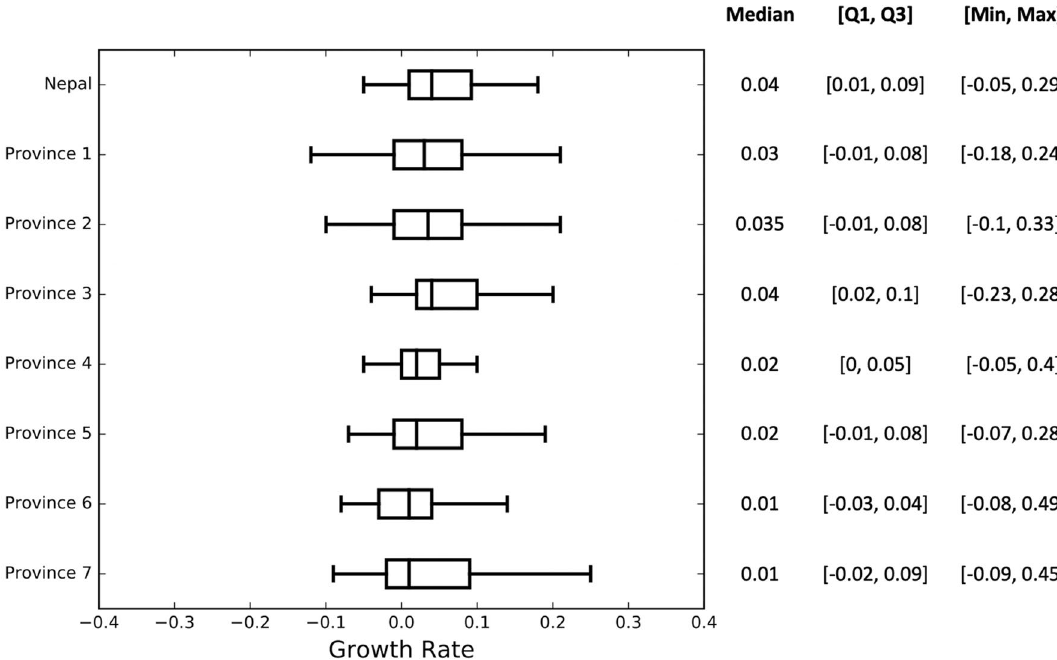
Figure 3. The five number summary (median, lower quartile, upper quartile, minimum, maximum) and the corresponding box plots of the daily exponential growth rates in Nepal and its provinces during the entire epidemic period considered.